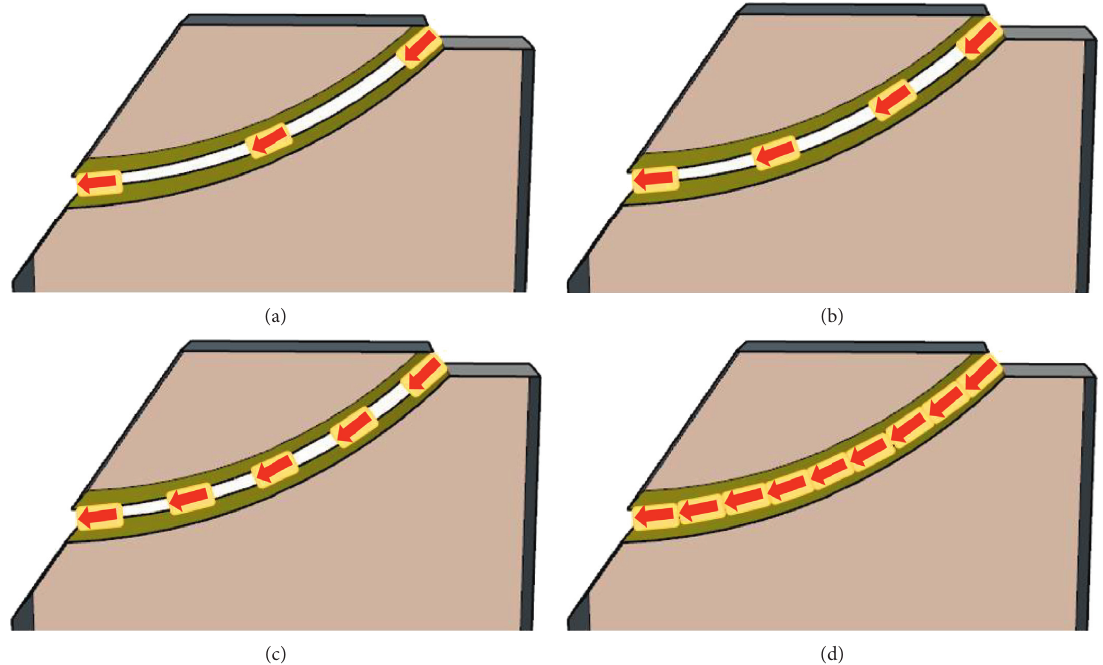
Figure 21: Changes in the sliding surface after loading at each stage. (a) Slip surface generation. (b) Slip surface extension. (c) The sliding surface continues to expand. (d) Penetration of sliding